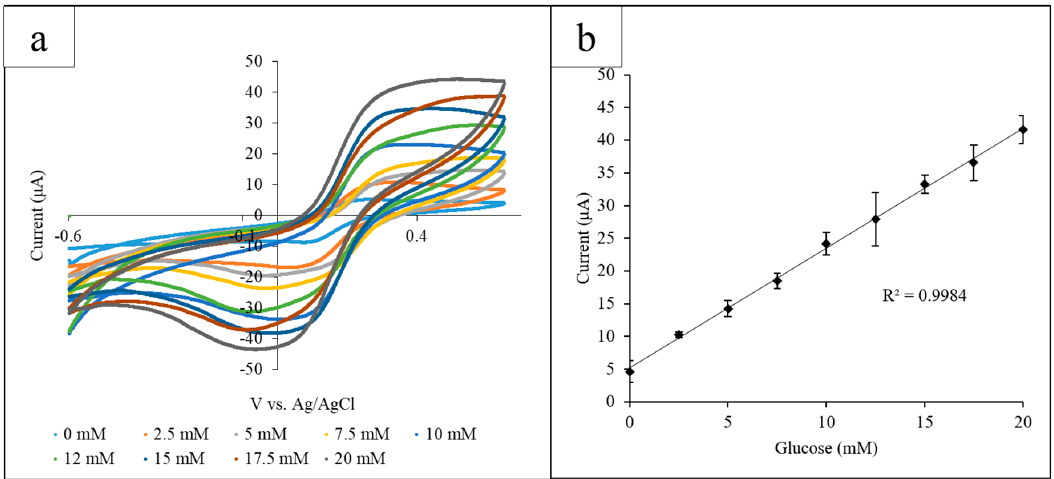
Figure 2. ( a ) Cyclic voltammograms for the increasing glucose concentrations measured using the paper platform in triplicate. The current output at the oxidation peak (0.45 V) increased proportionally with the glucose concentration; ( b ) the calibration curve measuring the current output at 0.45 V vs. glucose concentration. A linear correlation between the current and concentration was found to have an R 2 value of 0.998.